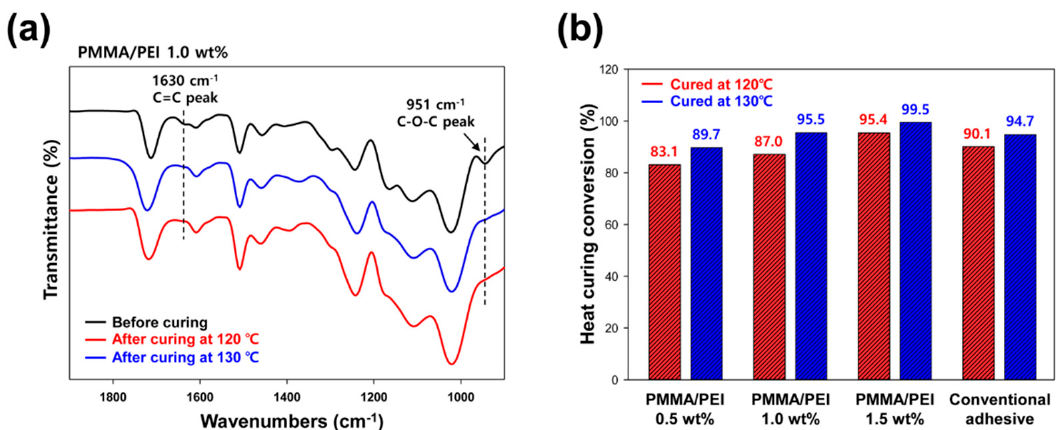
Figure 3. ( a ) FT-IR spectra of the UV/heat dual-curable adhesive with 1.0 wt% of PMMA/PEI nanoparticles before and after heat treatment at 120 or 130 °C. ( b ) Heat-curing ratios of conventional and new adhesives after heat treatment at 120 or 130 °C.